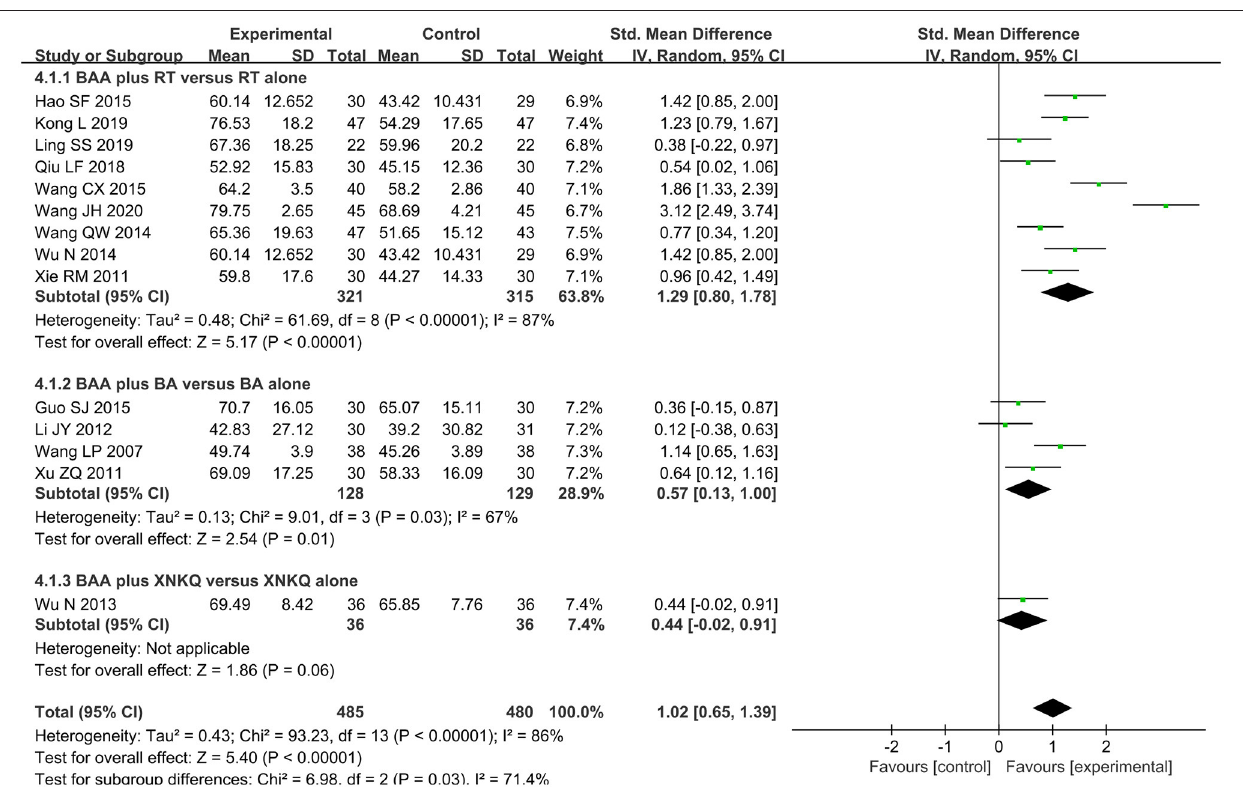
FIGURE 6 | Forest plot and meta-analysis of MBI. (BA, body acupuncture; BAA, Bo’s abdominal acupuncture; CI, confidence interval; MBI, modified Barthel Index; RT, rehabilitation training; XNKQ, Xingnao kaiqiao acupuncture).